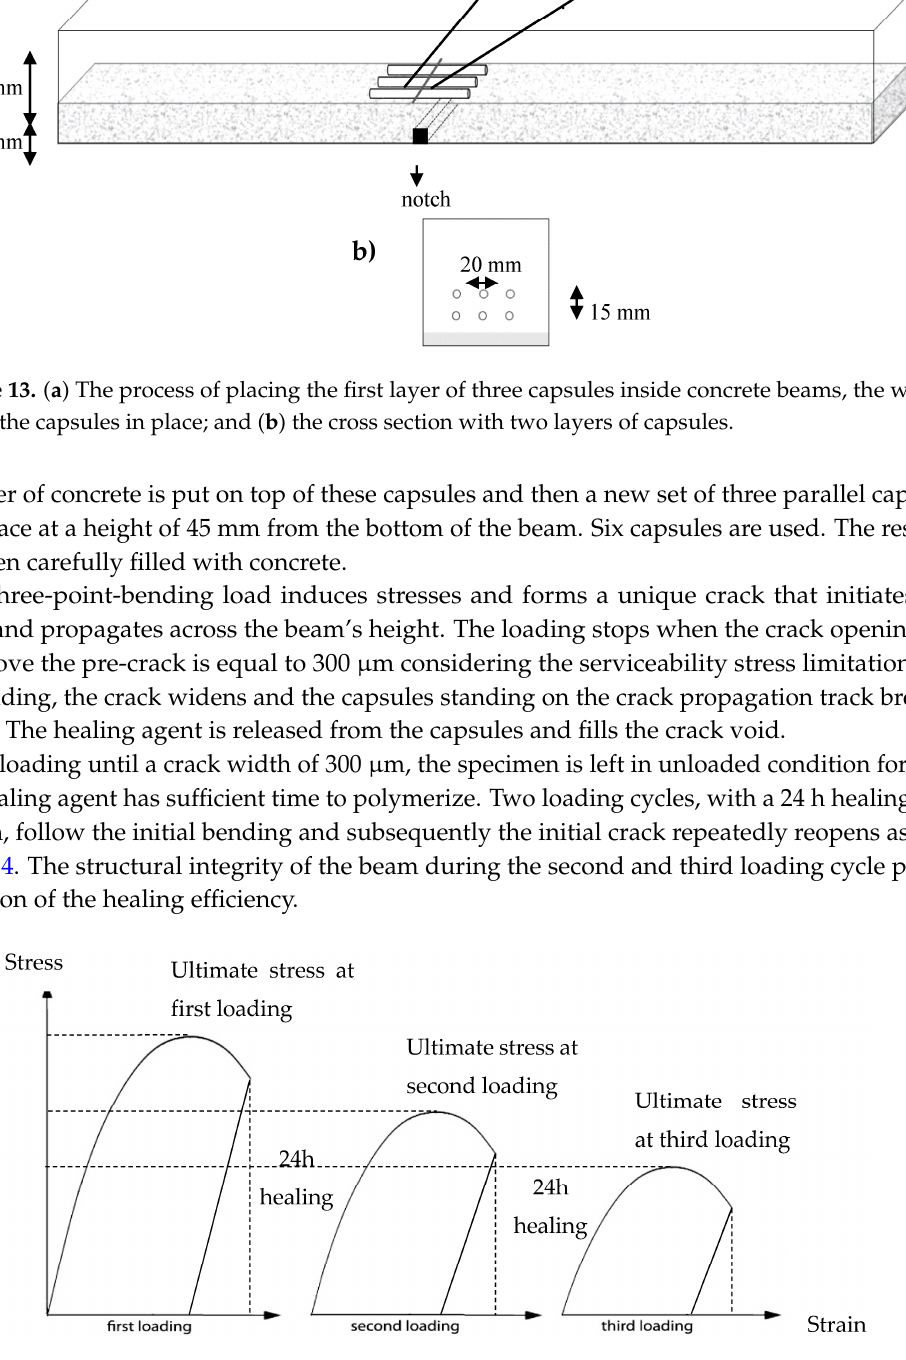
Figure 14. The mechanical response of the pre-cracked concrete beam under three-point-bending.